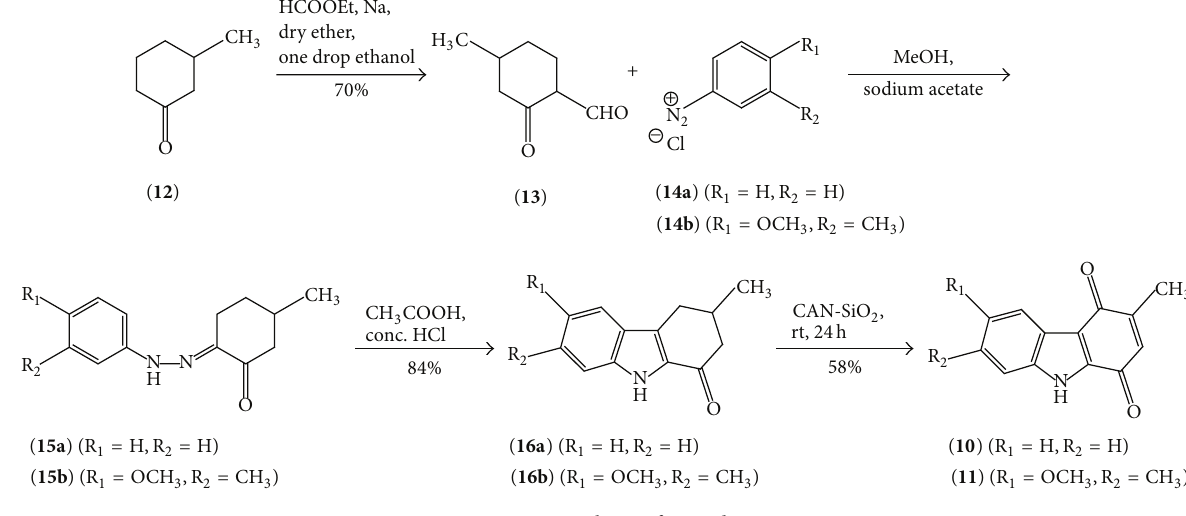
Scheme 1: Synthesis of 10 and 11